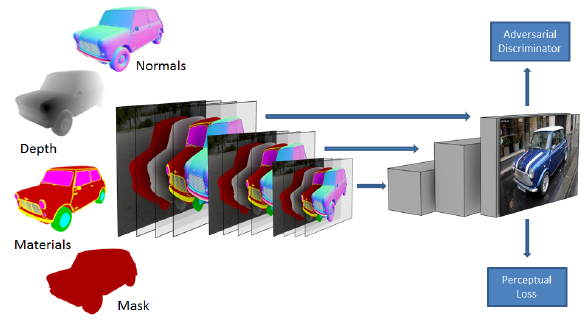
Figure 1. The pipeline of the GIS method